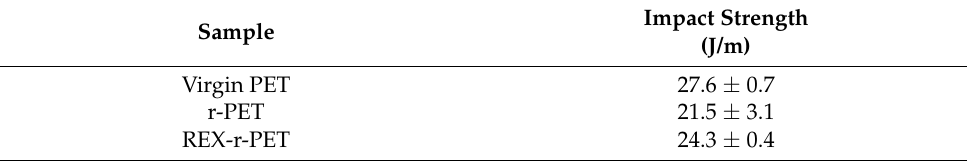
Table 6. The impact strength values of virgin PET, r-PET, and REX-r-PET.